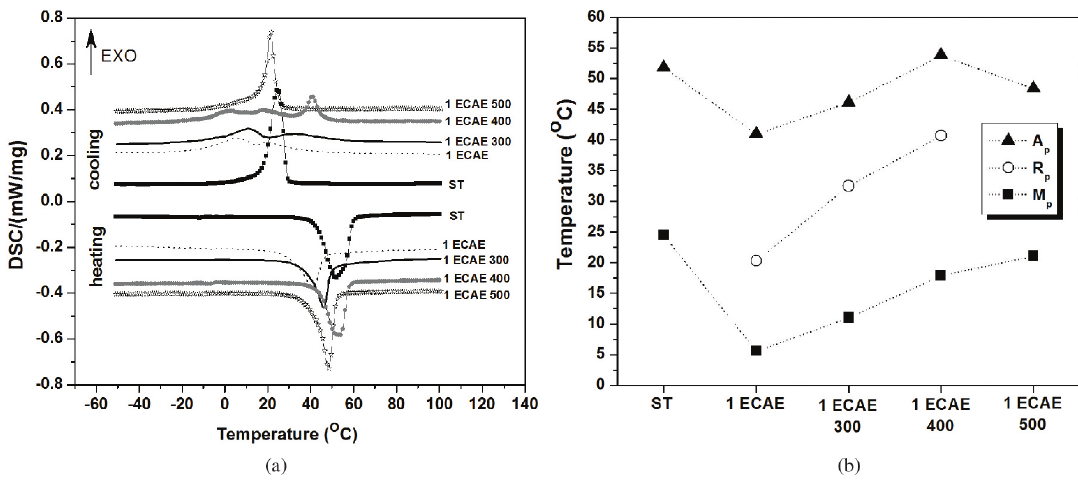
Figure 5. (a) Differential scanning calorimetry versus temperature and (b) Peak martensitic transformations temperatures M as a function of processing